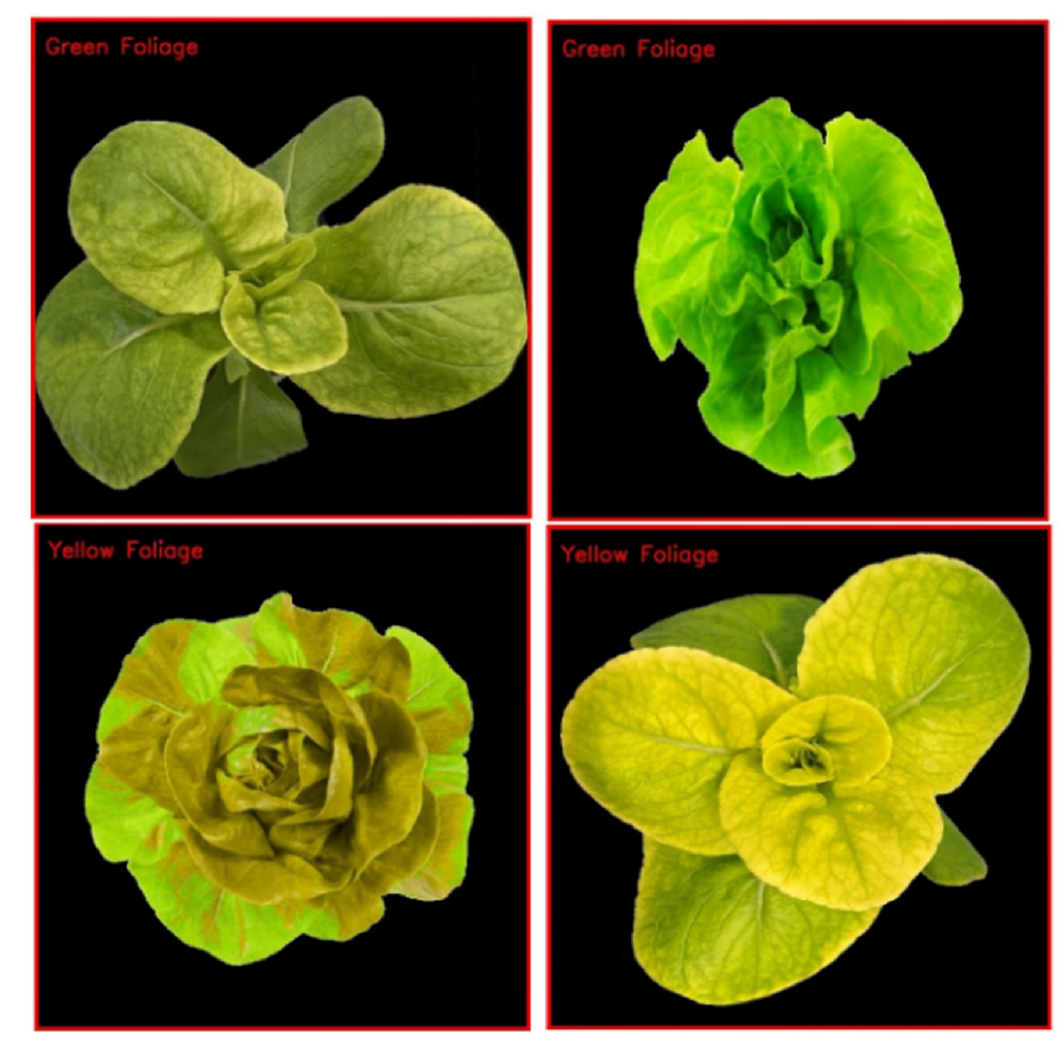
Figure 9. Example of correctly classified cases. Table 2. Performance metrics of existing